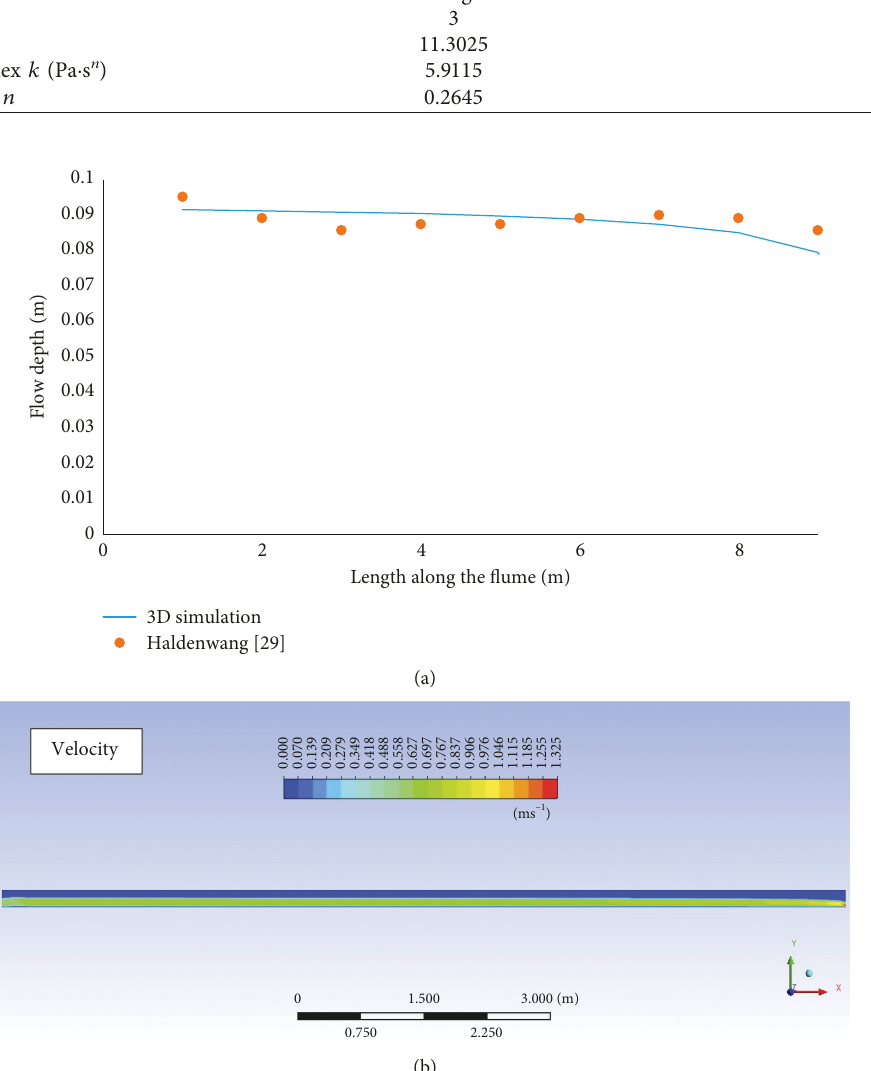
Figure 5: Case 2: (a) a comparison between the 3D CFD result and the Haldenwang [29] experimental results for flow depth along the channel axis at steady state. The channel length is 10m, and the width is 0.3m. The fluid properties of Case 2 are given in Table 2. (b) Velocity profile, the flow direction is left to right.